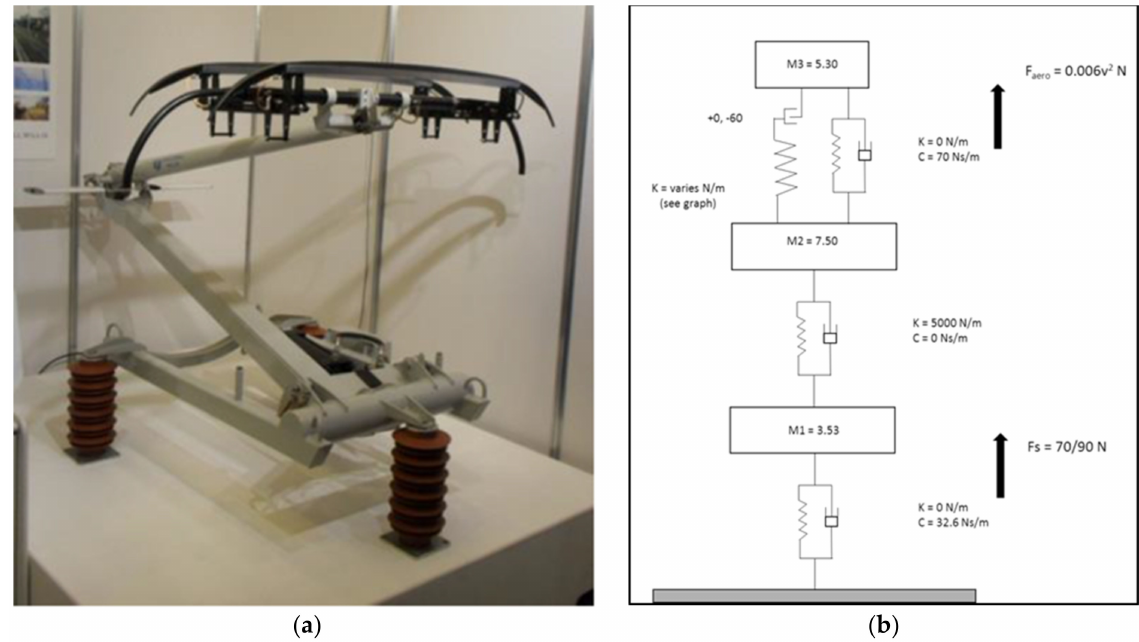
Figure 9. BW HSX250 pantograph ( a ) [29] and as implemented in the Ansys simulation model ( b